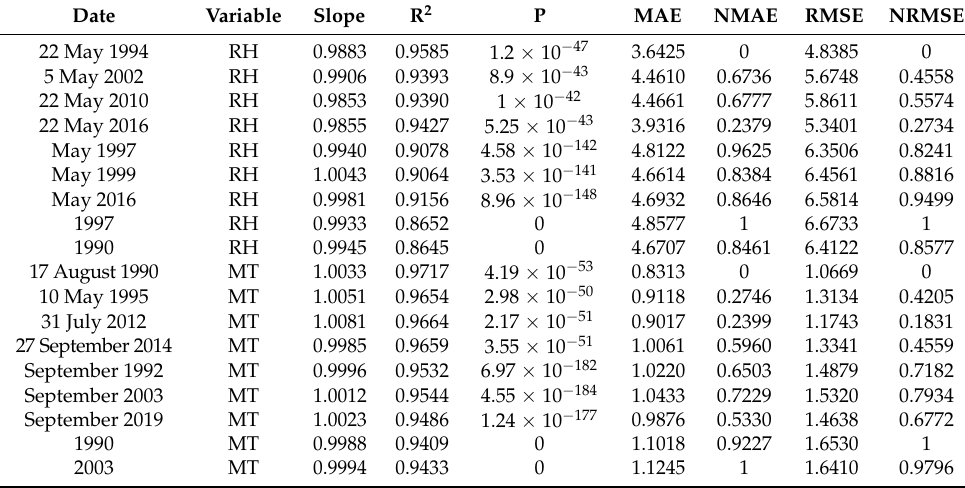
Table 1. Interpolation verification